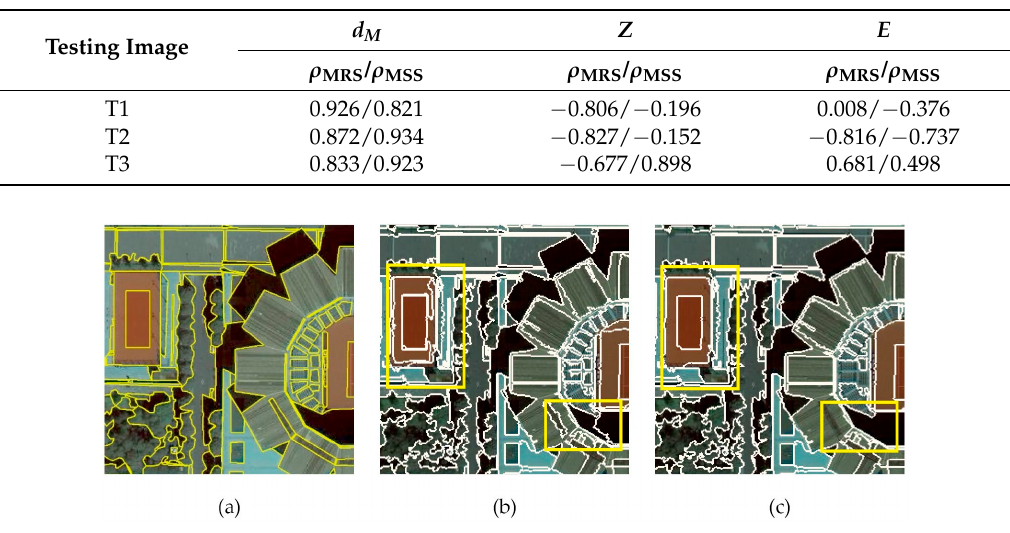
Figure 11. ( a ) Subset of the reference results for T2; ( b ) subset of segmentation results produced by MRS for T2 at scale 14; and ( c ) subset of segmentation results produced by MRS for T2 at scale 16. The main differences between ( b ) and ( c ) are highlighted by the yellow rectangles. The object boundaries of the reference image are delineated by yellow lines.